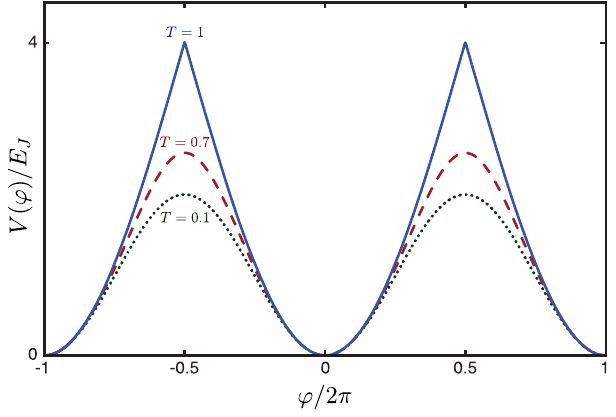
FIG. 12. Potential V ð φ Þ from Eq. (B3), normalized by E defined in Eq. (B4), at three different transmissions T . At T ≪ 1 , the potential recovers the usual cosine form familiar from standard SIS junctions, while larger T stiffens the potential compared to this case. Such stiffening yields relatively minor qualitative effects on the low-lying level structure and charge screening for the junction, even at perfect transmission where T ¼ 1